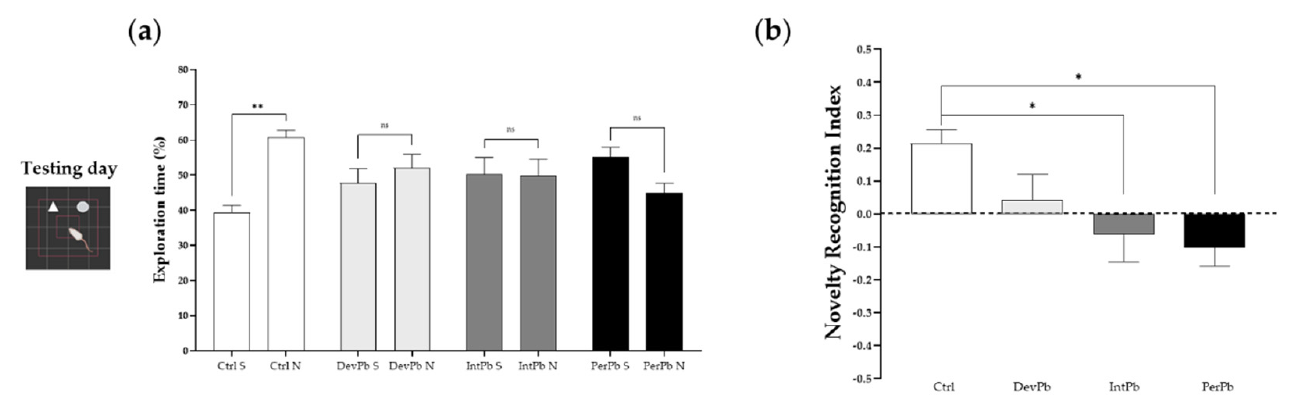
Figure 2. Long-term memory and learning assessment by the novel object recognition test: ( a ) Percentage of exploration time of sample (S) and novel (N) objects by each group. ( b ) Novelty recognition index calculated by the equation presented above. Values are the mean ± SEM. The asterisks denote statistically significant differences between groups; ns – not significant; * p < 0.05; ** p < 0.01; ( a ) paired Student’s t-test; ( b ) one-way ANOVA, with multiple comparisons (Dunnett’s test). Ctrl n = 18; DevPb n = 13; IntPb n = 14; PerPb n = 14.